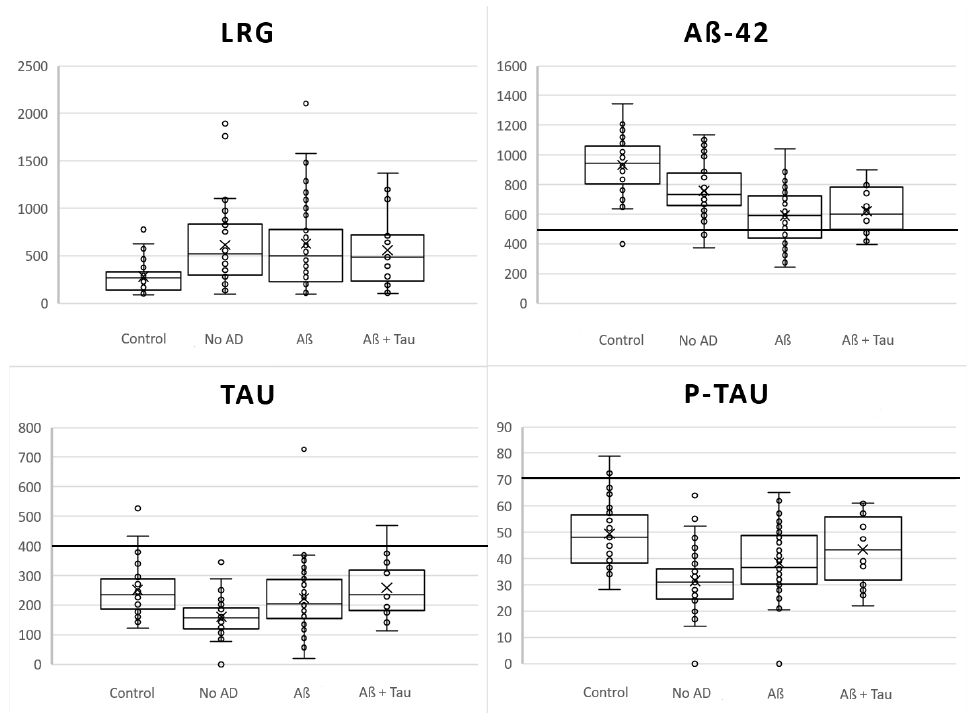
Figure 1. Boxplots for investigated cerebrospinal fluid (CSF) biomarker levels between study populations.